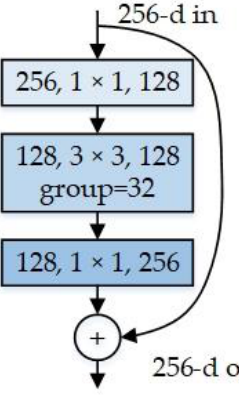
Figure 7. The equivalent block of ResNext.